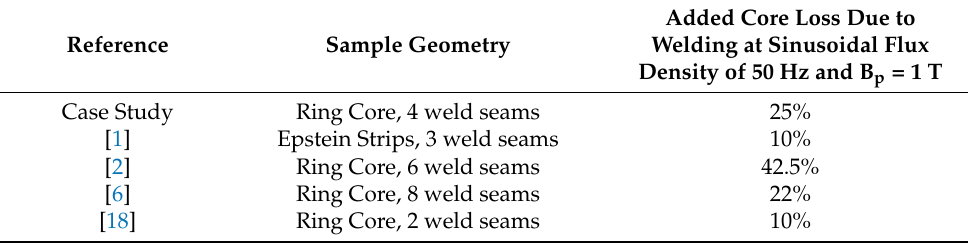
Table 3. Comparison of welded stator measurements with other examples found in literature.